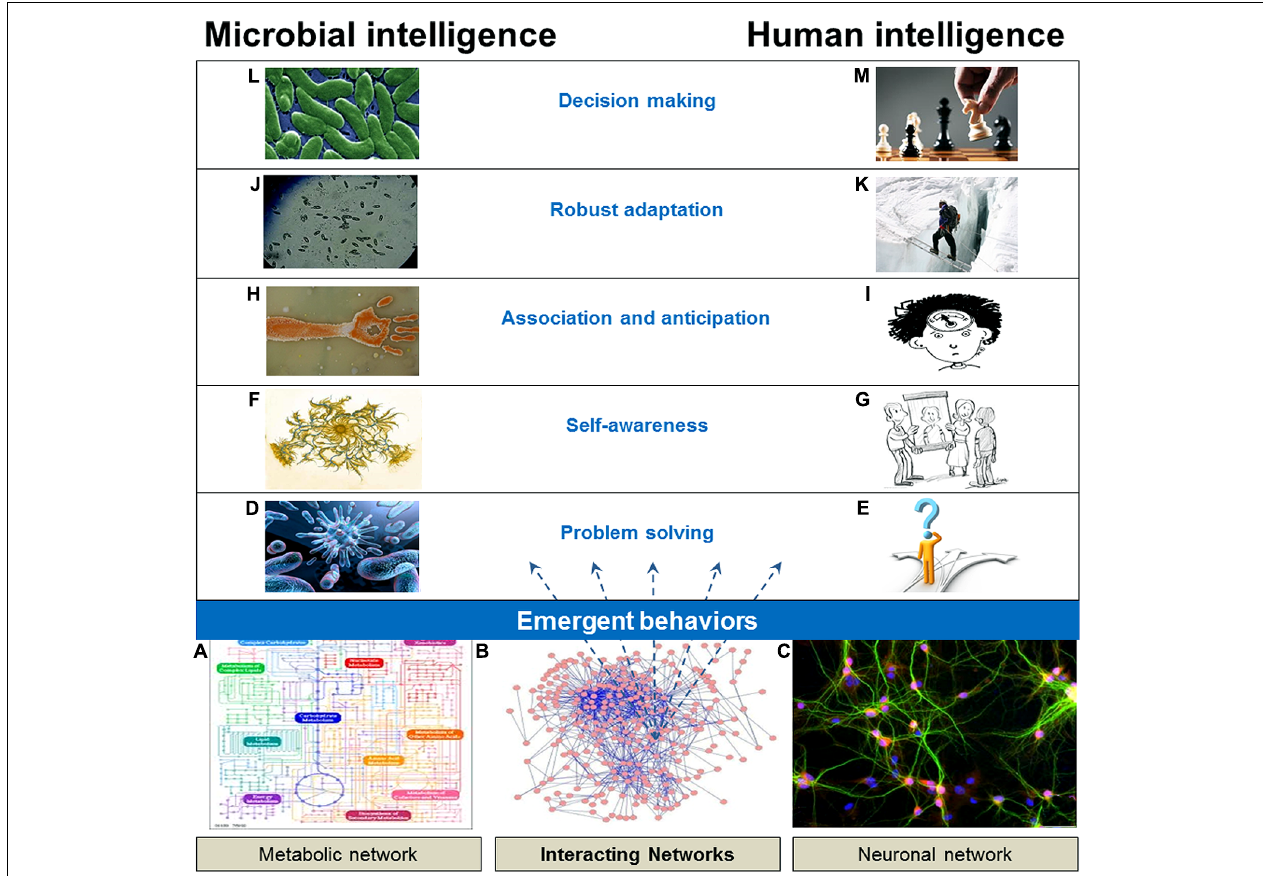
FIGURE 1 | Microbial intelligence vs. human intelligence. Microbes exhibit similar characteristics of intelligence as higher organisms and humans, such as decision making, robust adaptation, association and anticipation, self-awareness and problem solving capabilities. (A) Overview of metabolism as a molecular circuit;Taken from www.genome.ad.jp/kegg/kegg.html on September 23, 2002; (B) Supplementary Information for: “Topological network alignment uncovers biological function and phylogeny” from bio-nets.doc.ic.ac.uk/home/software/graal/; (C) Hippocampal Neurons, from learn.fi.edu/learn/brain/proteins.html; (D)